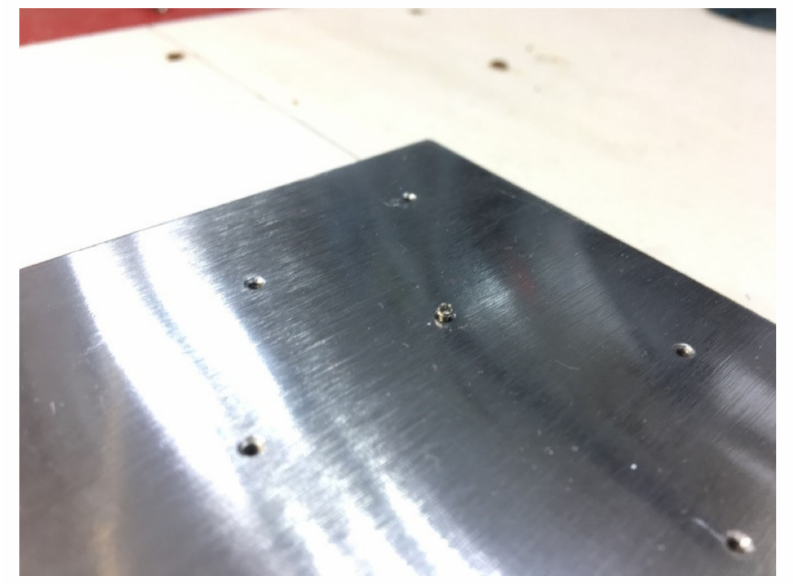
Figure 12. Tightening of the screw is complete and the manipulator returns to its original